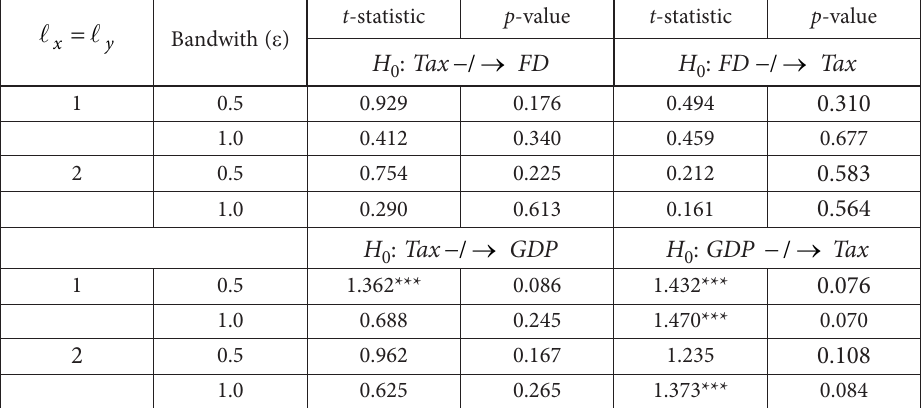
Table 13. Nonlinear causality